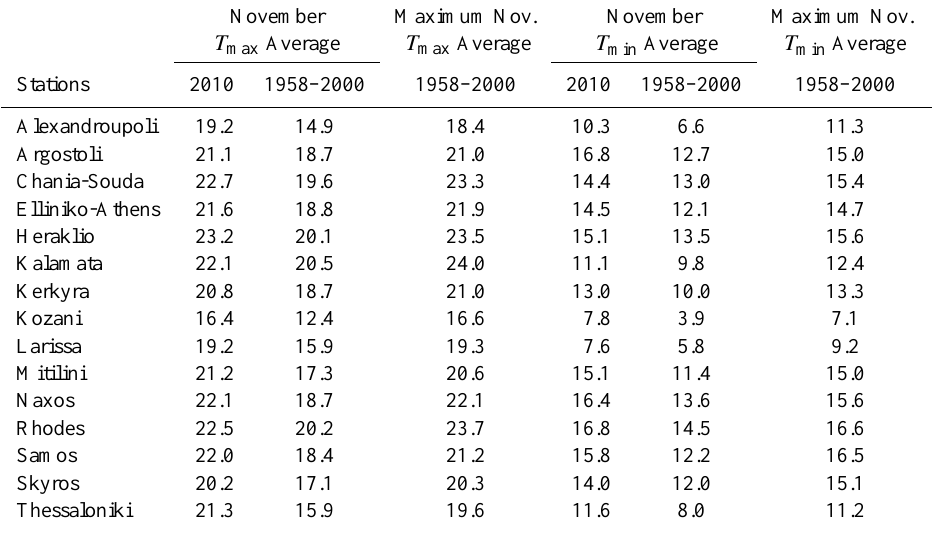
Table 2. Maximum and minimum November temperature mean values, for the year of 2010 and for the long term period 1958–2000 for the 15 stations under